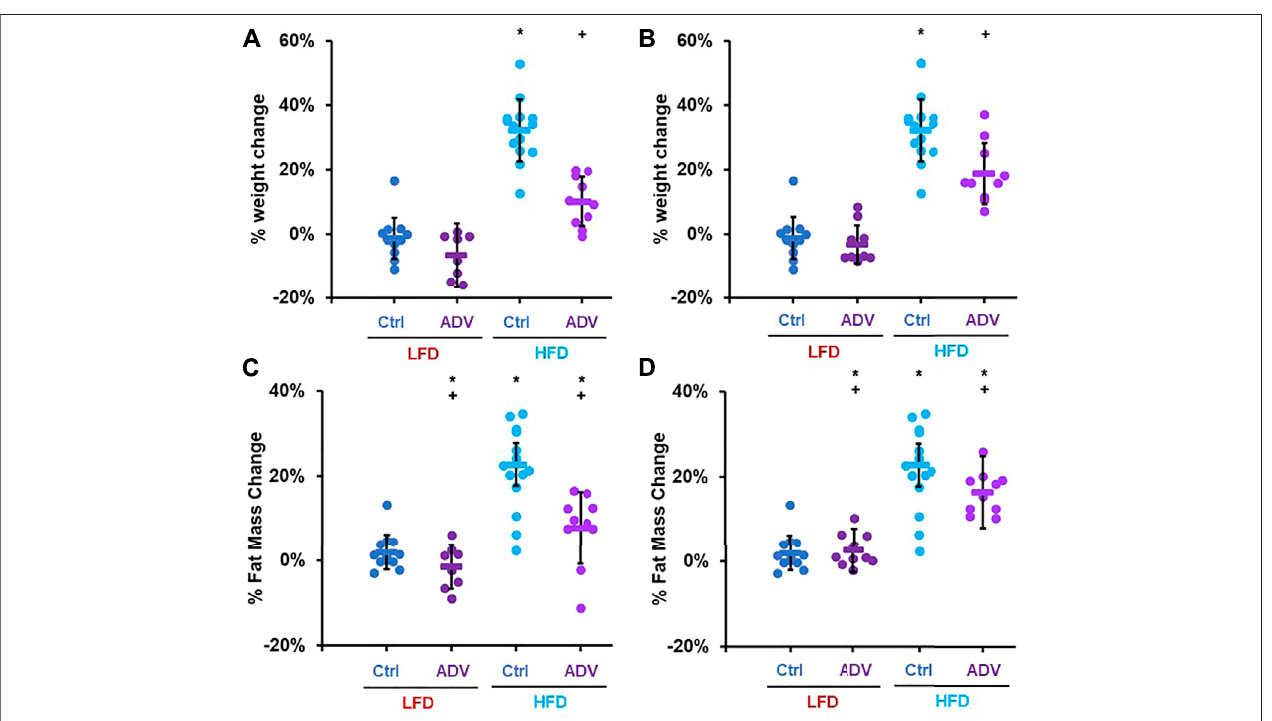
FIGURE6| Anti-obesogeniceffectsofadefovirdipivoxilinmice.PercentweightchangeinmicefedeitherLFDorHFDandtreatedwith210 mg/kgadefovirdipivoxil (ADV)inthechow (A) orbyintraperitonealinjectionof10 mg/kg/dayADV (B) PercentfatmasschangeinmicefedeitherLFDorHFDandtreatedwith210 mg/kgadefovir dipivoxil(ADV)inthechow (C) orbyintraperitonealinjection of10 mg/kg/dayADV (D) Circles:individualanimals,bars:average+-standarddeviation.*: p < 0.05vsLFD control, **: p < 0.01 vs LFD control, +: p < 0.05 vs HFD control, ++: p < 0.01 vs HFD control.